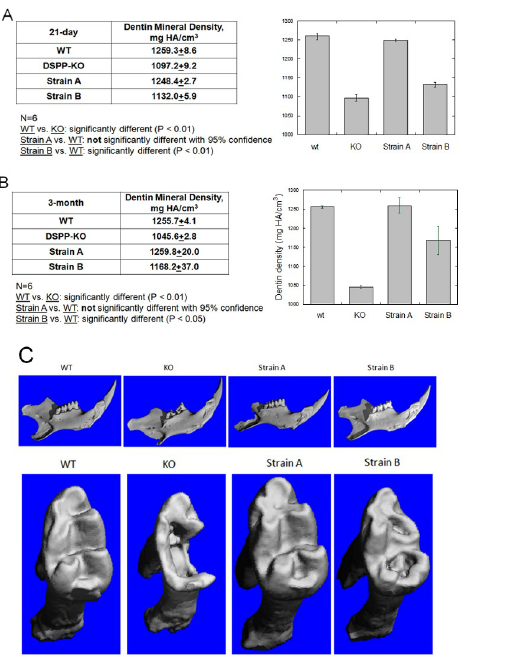
Fig 7. Analysis of mineral density and tooth structure in WT, DSPP KO, BAC-DSPP transgene Strains A and B. (A) Mineral density of M1 dentin at 21-day. (B) Mineral density of M1 dentin at 3-month. (C) 3D reconstruction of 2D microCT images of 21-day old mice. Top panel: incisor and molars. Bottom panel: molar 1. Erosion indicated by